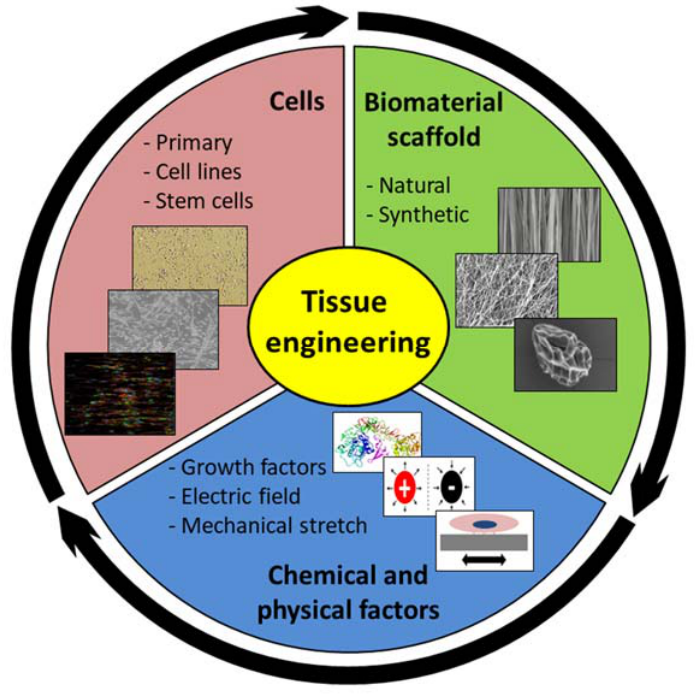
Figure 1. The three pillars of tendon/muscle tissue engineering: cells are cultured on a scaffold where they can attach, proliferate, or differentiate, giving them a phenotype relevant for the renewal of tissue functions. The mechanical and biochemical environments are of prime importance for triggering specific responses.